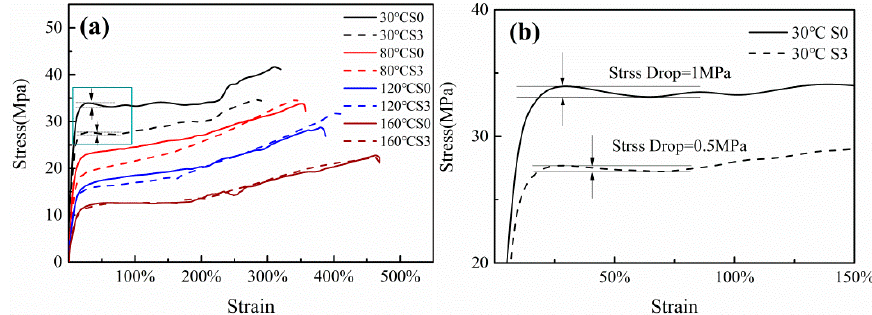
Figure 9. ( a ) the stress-strain curves of PA612 (solid line) and PA612/SO 2 (dotted line) films at different temperature and ( b ) the zoom-in view of the curves at 30 °C.